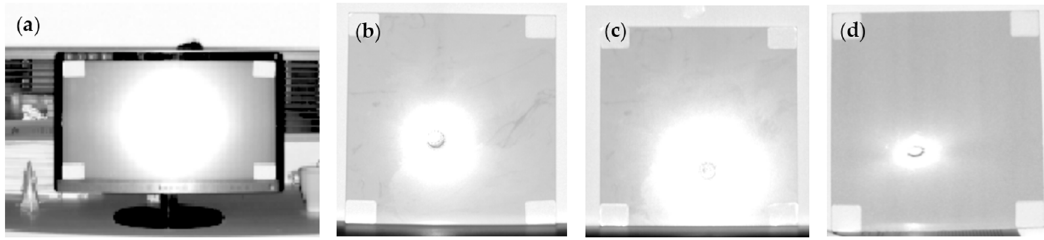
Figure 3. Original intensity images created by Faro SCENE 4.8: ( a ) computer screen; ( b ) ceramic tile; ( c ) iron sheet; ( d ) polyethylene panel. Specular highlight phenomena (bright regions) are present on all targets.